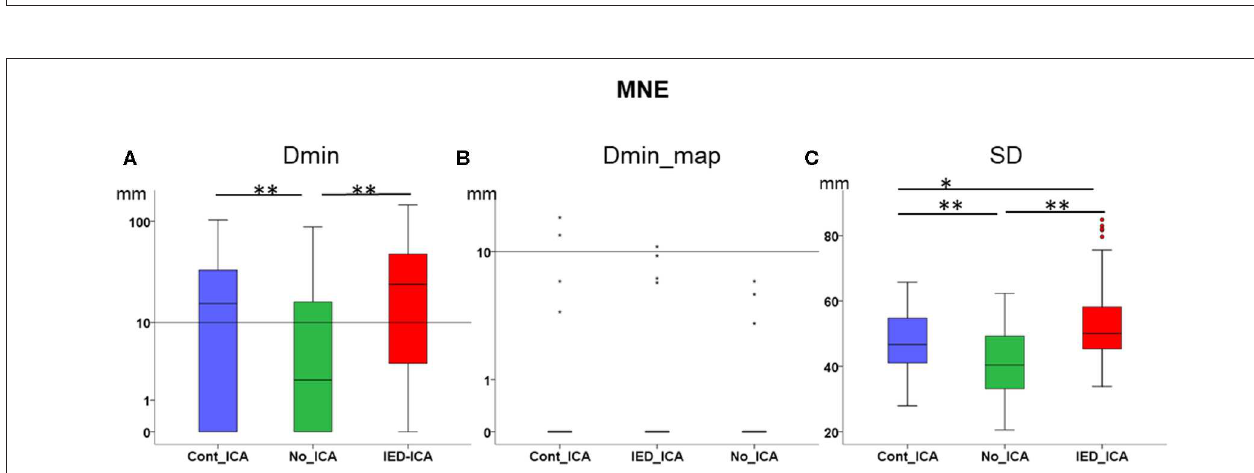
FIGURE 2 | Effect of ICA on ECD. (A) Dmin was not significantly different across ICA approaches as compared to no_ICA. Note that the y axis is in logarithmic scale. The median for all three methods was close to or lower than 1cm. (B) Dmin of the dipole projection to the closest cortical point. No significant difference was found across ICA approaches as compared to no_ICA.